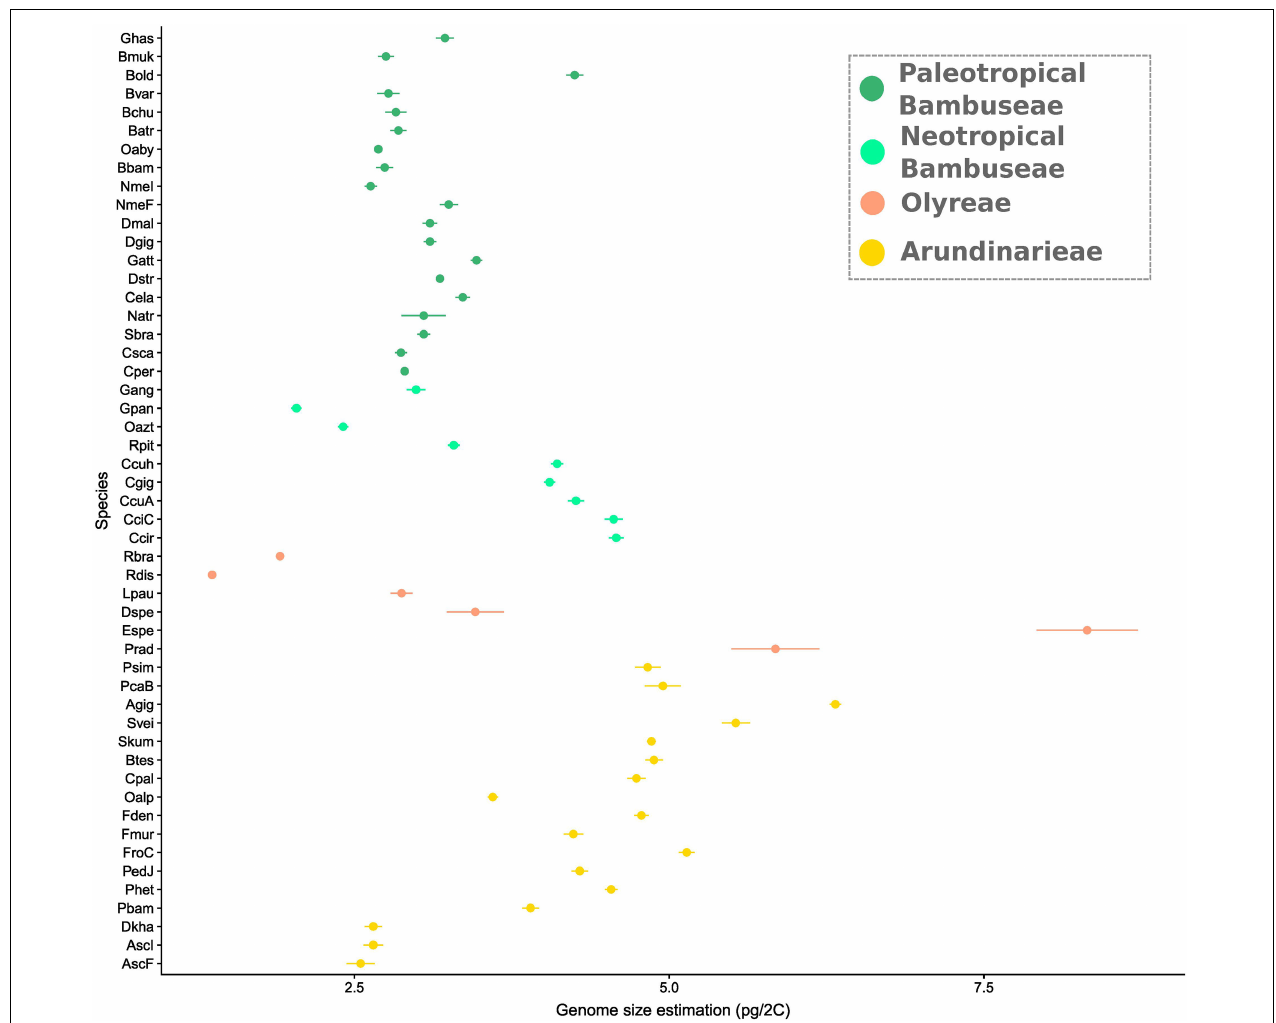
FIGURE 5 | Genome size variation in bamboo. Estimations were done using flow cytometry. Error bars represent standard deviations. Dots are clade-colored with yellow showing temperate bamboos, orange dots are herbaceous, light green is Neotropical woody and dark green is Paleotropical woody. Taxa are ordered along the Y axis in the phylogenetic relatedness order depicted in Figure 2